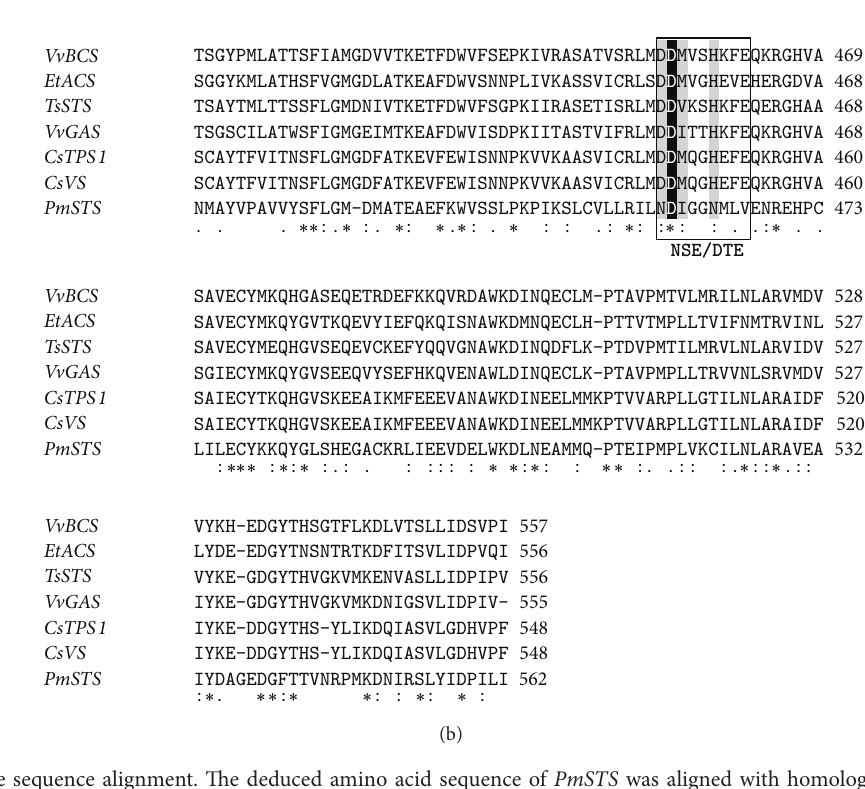
Figure 2: Multiple sequence alignment. The deduced amino acid sequence of PmSTS was aligned with homologues identified from the BLASTX analysis. Sequences highlighted in black indicate identical residues, while those in grey indicate similar residues. The conserved motifs RXR, DDXXD, and NSE/DTE are marked. PmSTS : sesquiterpene synthase [ P. minus ]; TsSTS : sesquiterpene synthase [ Toona sinensis ];